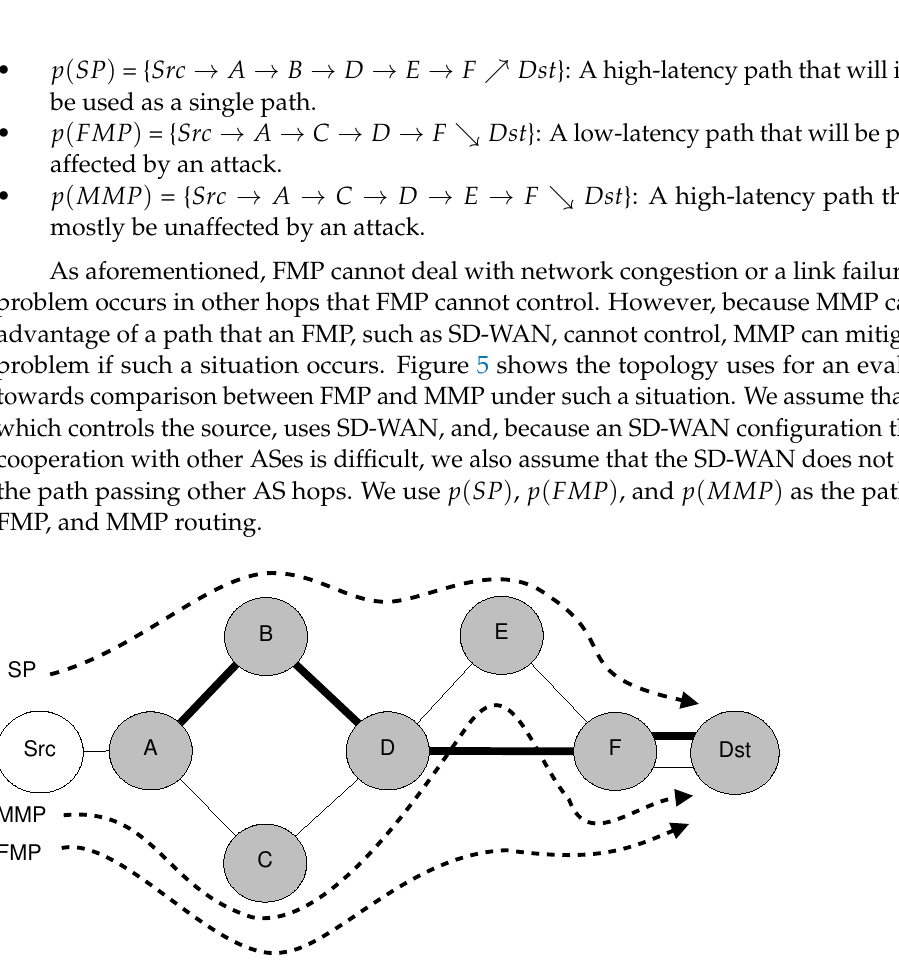
Figure 5. Topology used for comparison between MMP and FMP. The solid bold line indicates heavy traffic. The scenario is a case in which the traffic congestion affects both paths of FMP and MMP, whereas the alternative path found by MMP does not.